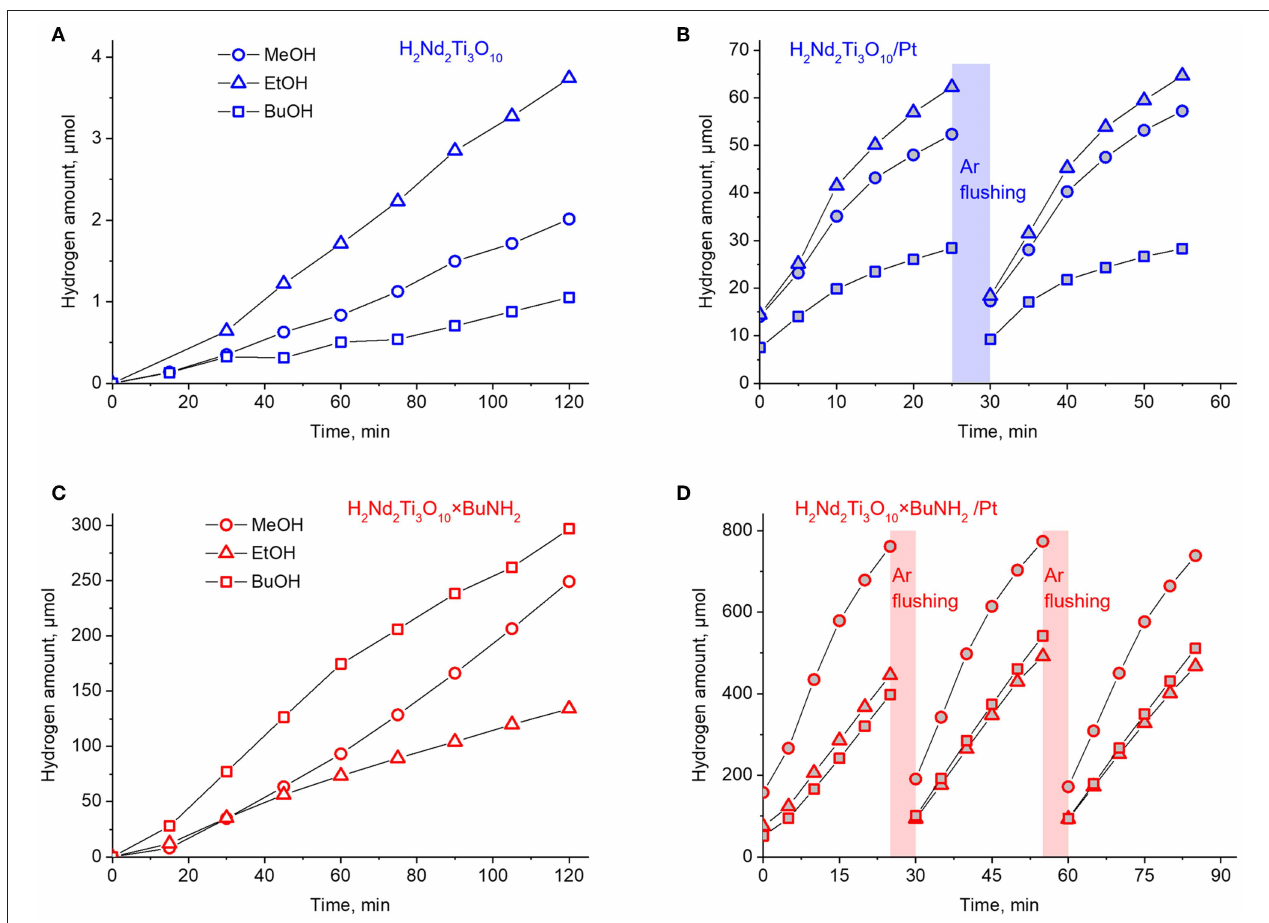
FIGURE 9 | Kinetic curves of photocatalytic hydrogen evolution over H 2 Nd 2 Ti 3 O 10 (A) , H 2 Nd 2 Ti 3 O 10 /Pt (B) , H 2 Nd 2 Ti 3 O 10 × BuNH 2 (C) , and H 2 Nd 2 Ti 3 O 10 × BuNH 2 /Pt (D) .